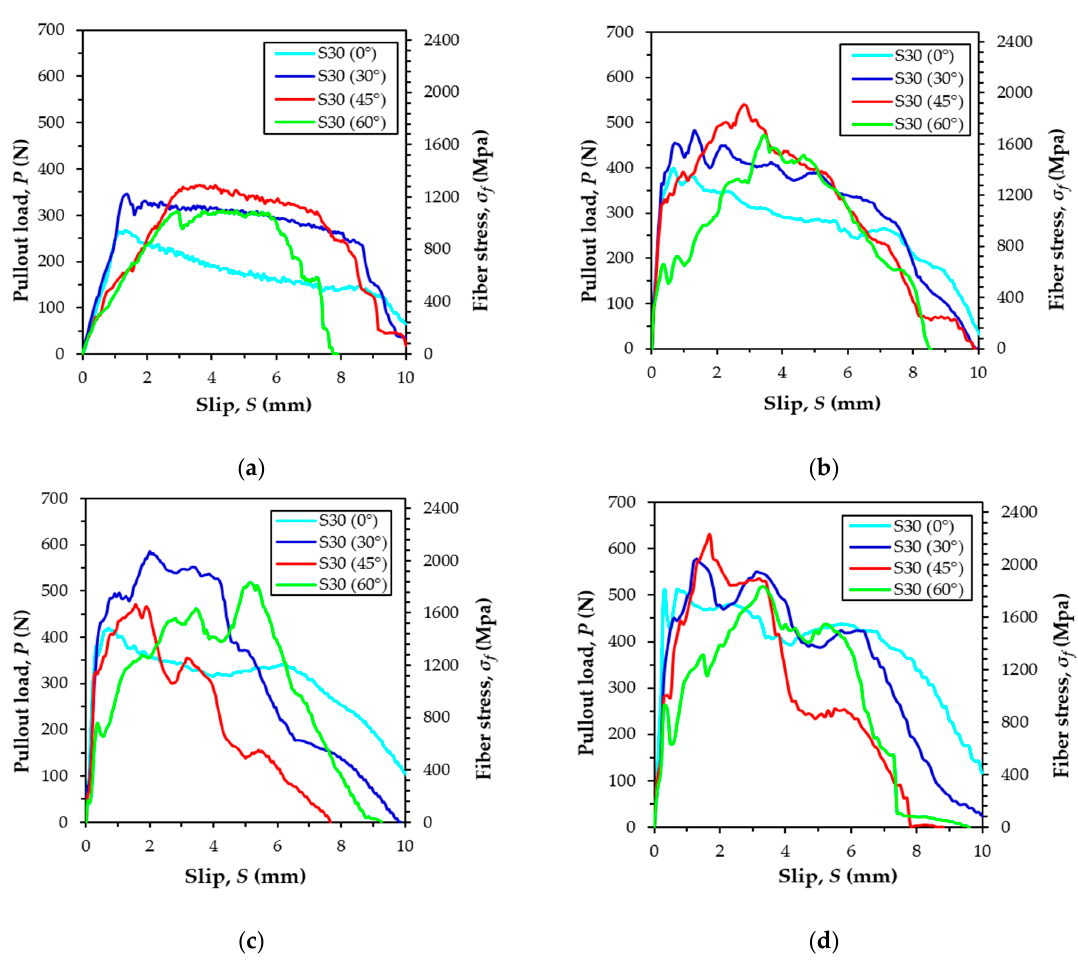
Figure 6. Average pullout load versus slip curves on straight (S)-fibers at various loading rates: ( a ) quasi-static, ( b ) air pressure of 2 kN, ( c ) air pressure of 5 kN, and ( d ) air pressure of 8 kN.